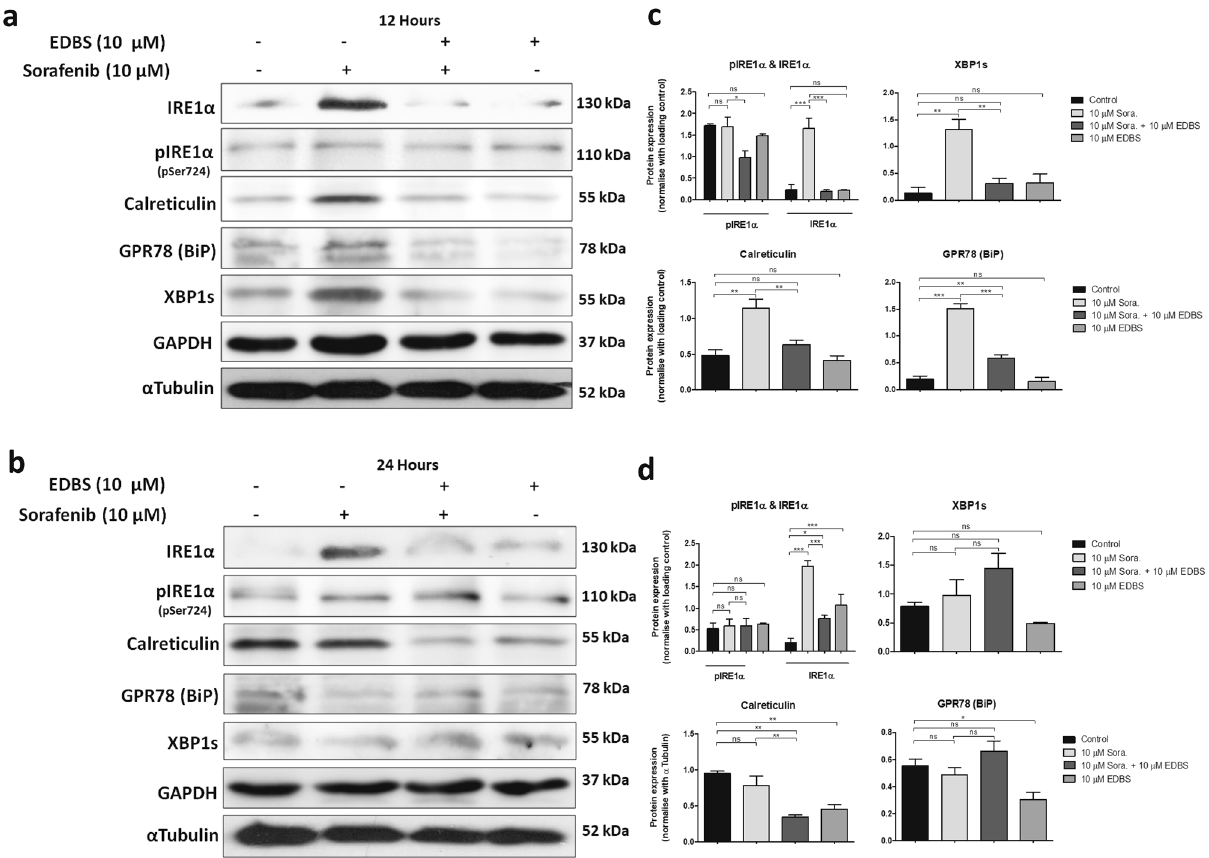
Figure 7. Higher concentration of sorafenib induced UPR pathway associated with IRE1α-XBP1s axis. ( a , b ) Western blot analysis showing IRE1α, pIRE1α, GRP78 (BiP), calreticulin and XBP1s expression after treatment with 10 µM sorafenib treatment for 12 h and 24 h. αTubulin and GAPDH were used as a loading control. The immunoblots were depicted the influence of inhibitor of IRE1α 3-Ethoxy-5,6-dibromosalicylaldehyde (EDBS) on 10 µM sorafenib induced protein level of IRE1α, pIRE1α, GRP78 (BiP), calreticulin and XBP1s. ( c , d ) Protein expression level were quantified using ImageJ software. GAPDH and αTubulin were used as a loading control. Relative protein ratios (normalized with loading control) were shown in a plot graph. Data represent mean ± s.d. from three independent experiments (ns > 0.05, *P < 0.05; **P < 0.01, ***P < 0.001 One-way analysis of Dose dependent sorafenib induced UPR is associated with functional activation of the IRE1α‑XBP1s axis. To further confirm the role of the IRE1α-XBP1s axis of the UPR to ER stress, we ana- lysed the protein expression patterns of related genes through western blot. It was found that the IRE1α were significantly overexpressed in LX2 cells on treatment with 10 μM sorafenib at both the 12 h and 24 h time points (Fig. 7a–d). During ER stress IRE1α activates the endoribonuclease domain, which primarily acts through XBP1 37 . Here the protein levels of XBP1s were also enhanced in LX2 cells after treatment with 10 μM sorafenib for 12 h. Calreticulin and GRP78 (BiP) chaperon proteins that bind to misfolded or un-folded proteins were also upregulated after sorafenib treatment for 12 h (Fig. 7a,c). As per literature IRE1α autophosphorylation enhanced further oligomerization of the protein to stimulate RNase activity 38 . In contrast, sometimes IRE1α can bypass its autophosphorylation to cleave XBP1 for activation of the UPR pathway 36 . In our results we found that phosphorylation of IRE1α (pIRE1α) were unaltered in LX2 cells without or with 10 μM sorafenib at both 12 and 24 h of treatment. To further explain the effect of ER stress on the cytoplasmic vacuolation-mediated cell death, we blocked the ER stress signalling using 3-Ethoxy 5, 6-dibromosalicylaldehyde (EDBS). EDBS is a non-competitive reversible inhibitor that binds specifically to the IRE1α protein to inactivate its endoribonuclease activity 39 . To inhibit the IRE1α protein we pre-treated the LX2 cells with 10 μM EDBS for 60 min prior to exposure of sorafenib for 12 h and 24 h. EDBS pre-treatment decreased the expression of the GRP78, IRE1α, XBP1s and calreticulin after 12 h of 10 μM sorafenib treatment (Fig. 7a,c). There was a very marginal reduction of basal level pIRE1α in EDBS pre-treated LX2 cells after sorafenib treatment for 12 h. We again confirmed the overexpression of IRE1α and its suppression through pre-treated EDBS after 10 μM sorafenib treatment in rat HSC-T6 cells for both 12 h and 24 h (Suppl. Fig. S6), suggesting the involvement of IRE1α mediated UPR pathway in sorafenib induced ER stress. Most strikingly, when we pre-treated human HSCs, LX2 cells and rat HSC-T6 with EDBS there was signifi- cant reduction in cytoplasmic vacuolation after 12 h of 10 μM sorafenib treatment, whereas when sorafenib